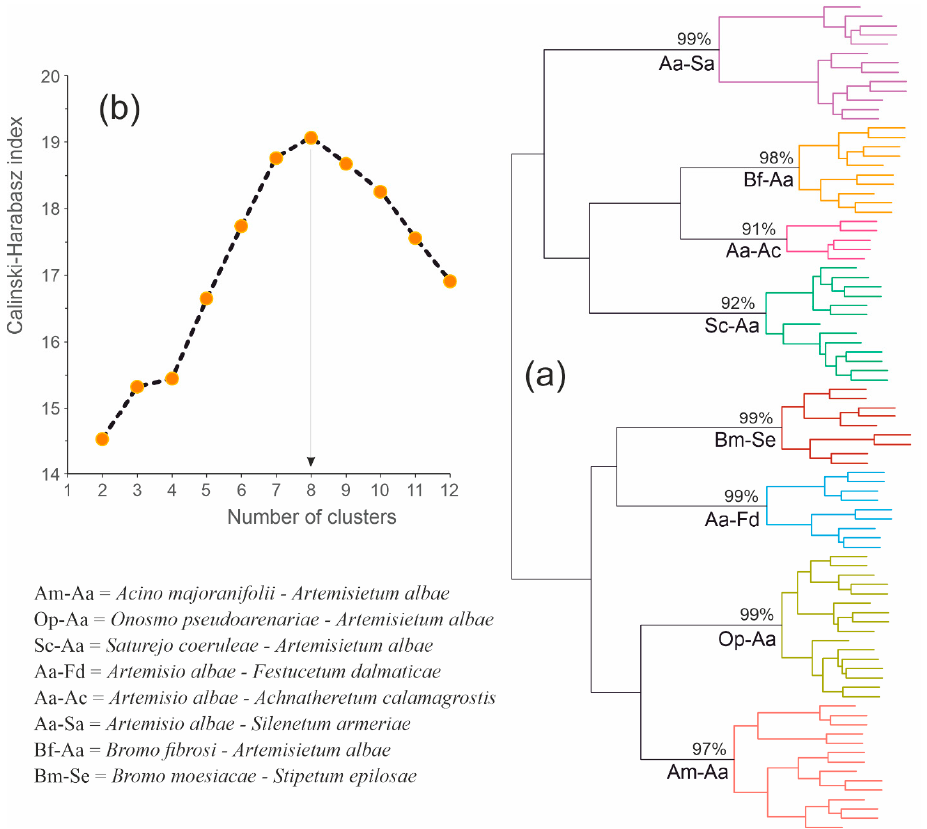
Figure 2. Hierarchical, agglomerative classi fi cation of the 89 relevés ( a ) and the distribution of the Calinski–Harabasz index by number of clusters ( b ). The percentage values refer to the stability of the eight clusters retained and marked in di ff erent colours. eight clusters retained and marked in different